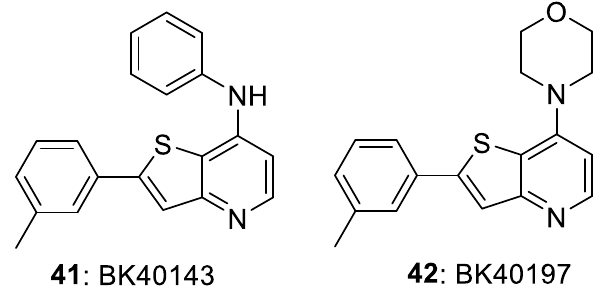
Figure 9. DDR inhibitors in brain disease.